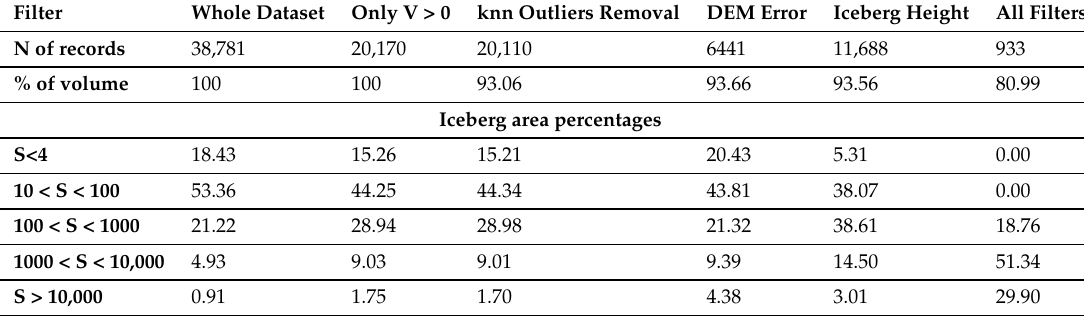
Table 4. Statistical summary of the subsets of icebergs generated by different filtering